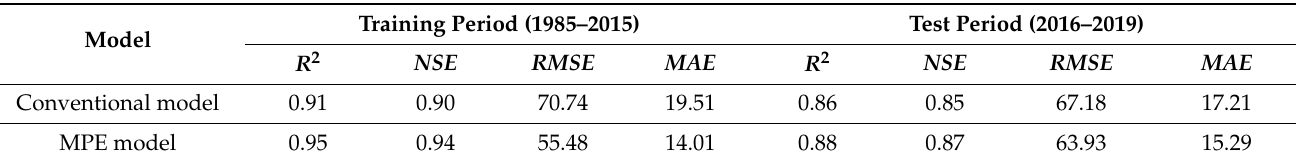
Table 3. Comparison of performance of both models on training and test data.